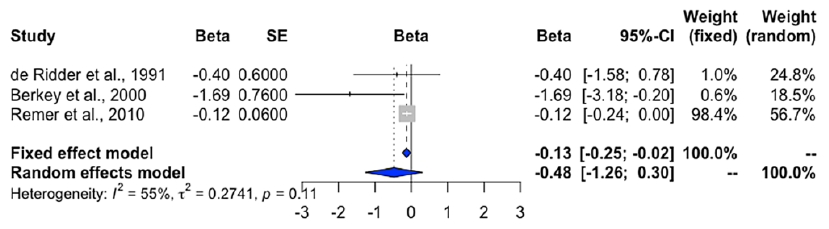
Figure 5. Forest plot of the beta regression coefficient of age at menarche onset for every 1 g/day increase of animal protein intake. Definition of abbreviations : Beta, beta coefficient; SE, standard error.